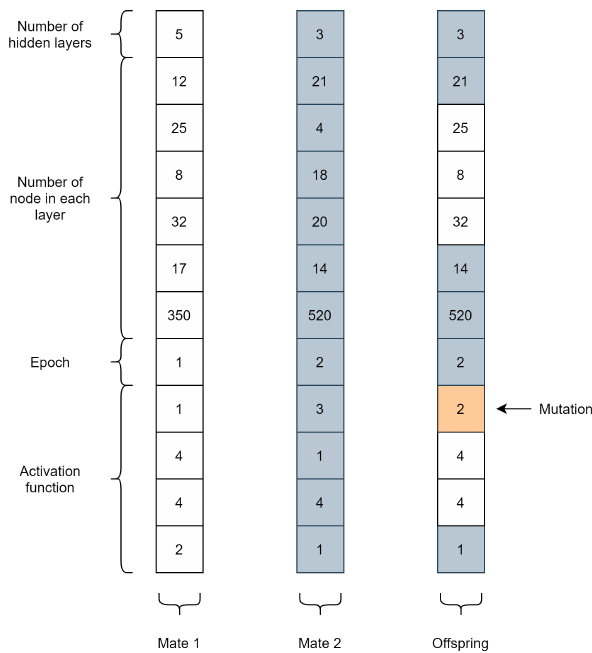
Figure 6. Example of genes of two mates and their